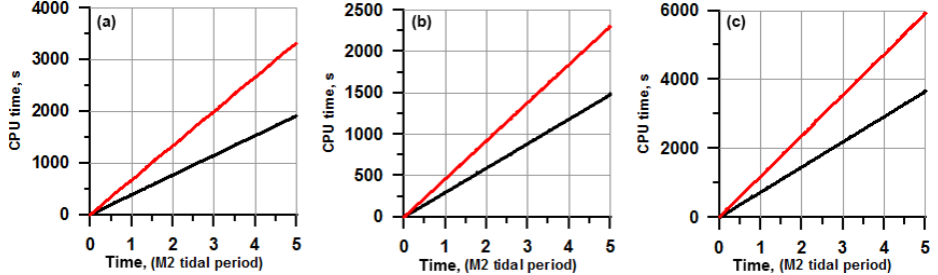
Figure 14. CPU time on two meshes, MESH-1 (black line) and MESH-2 (red line), for the Sylt–Rømø experiment. The CPU time for 3-D velocity (a) , external mode (b) , and the total CPU time (c) .